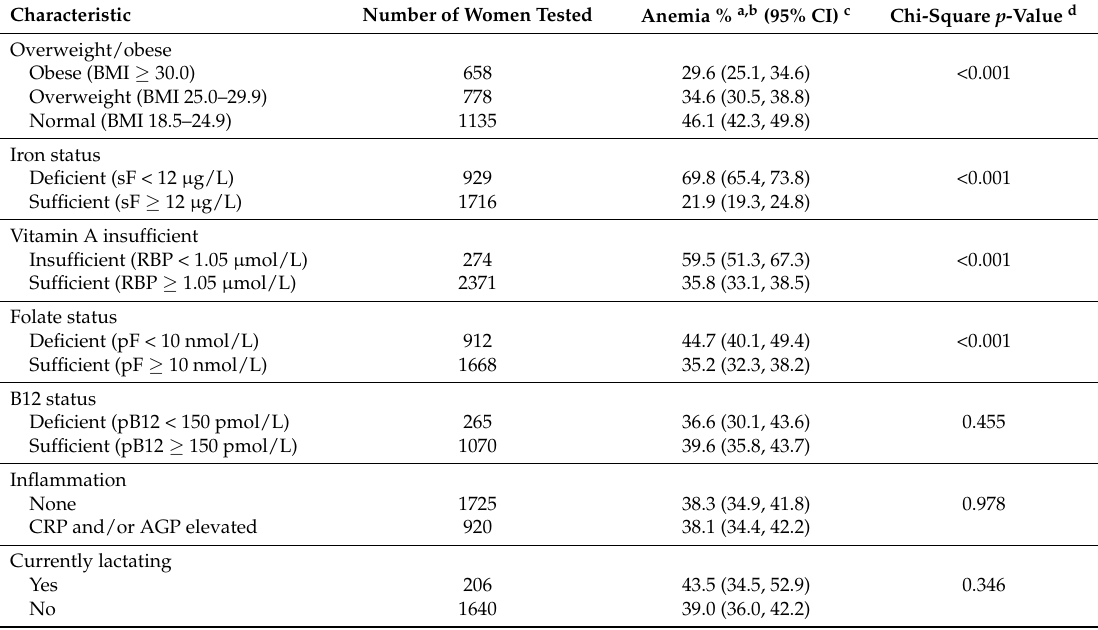
data. a Percentages weighted for non-response and survey design. b Anemia defined as hemoglobin <110 g/L